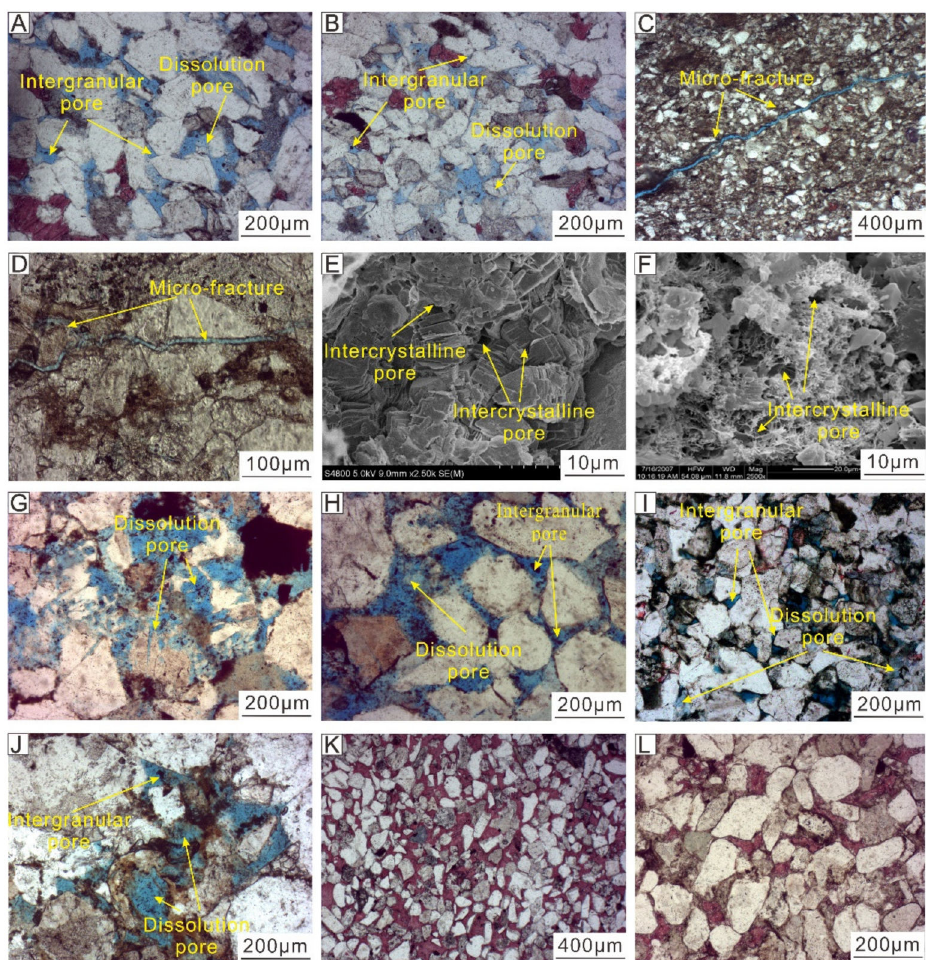
Figure 4. Microscopic characteristics of pore systems in the E s4 sandstone reservoirs. ( A , B ) Intergran- ular pores and dissolution pores; ( C , D ) Micro-fractures; ( E , F ) Intercrystalline pores; ( G ) Dissolution pores; ( H , I ) Intergranular pores and dissolution pores; ( J ) Residual intergranular pores and dissolu- tion pores; ( K , L ) Extensive carbonate